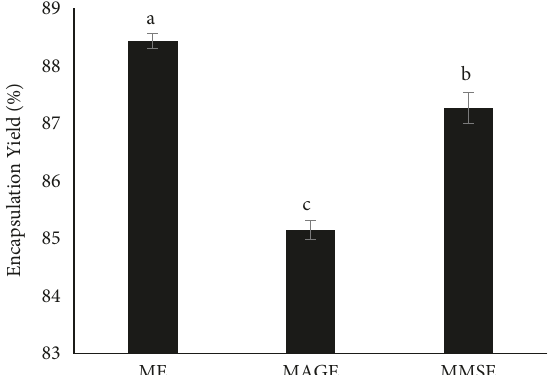
Figure 2: Encapsulation yield of microcapsules affected by dif- ferent wall materials: maltodextrin/extract (ME), maltodextrin/ arabic gum/extract (MAGE), maltodextrin/modified starch/extract (MMSE). different lowercase letters show statistically significant differences ( p < 0 .